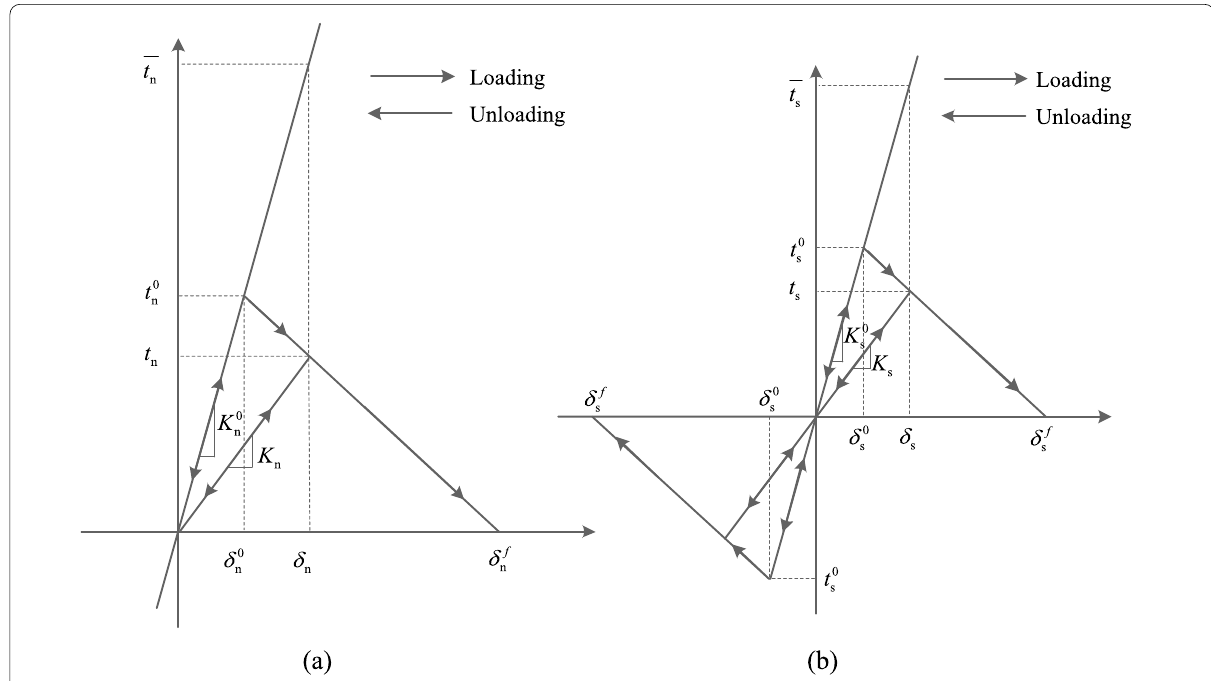
Fig. 1 The bilinear traction–separation model: ( a ) normal constitutive model and ( b ) tangential constitutive model (Maimí et al.,